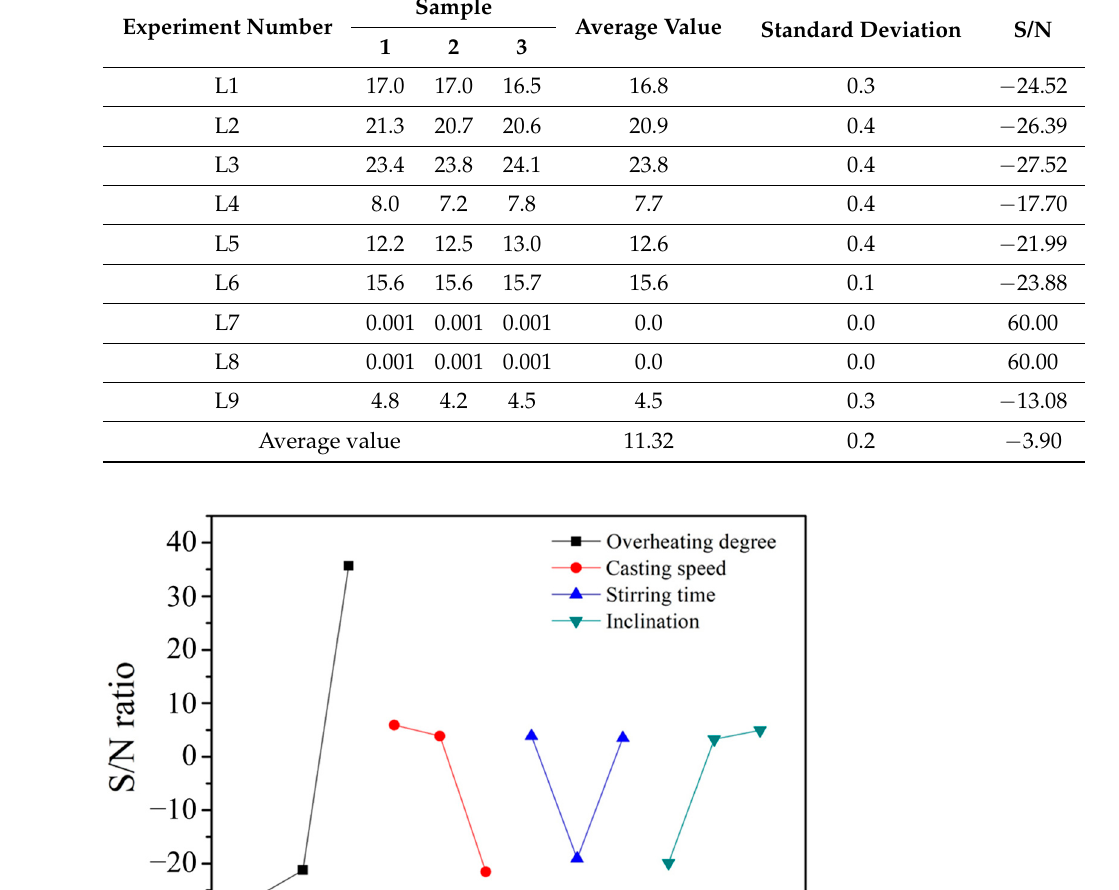
Table 6. Individual peeling widths, average peeling widths, standard deviations, and S/N ratios of samples L1–L9.